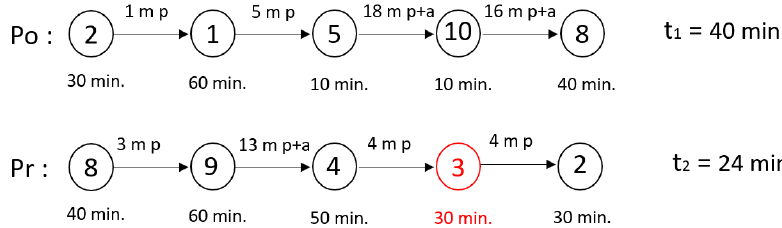
Figure 19. The outward path after adding node 3 to G r .